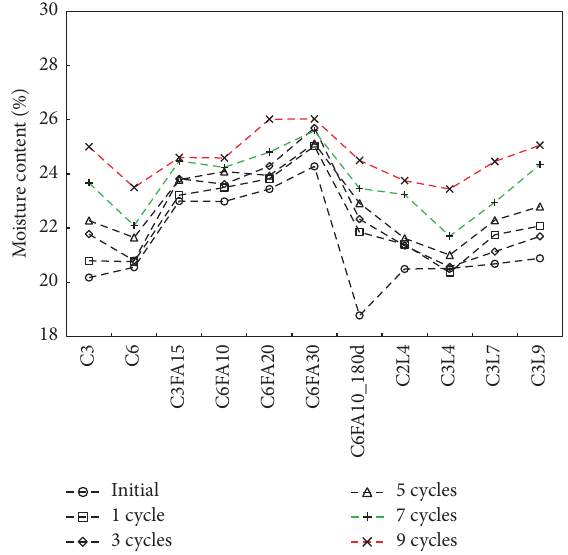
Figure 11: Moisture content of stabilized samples before and after frost